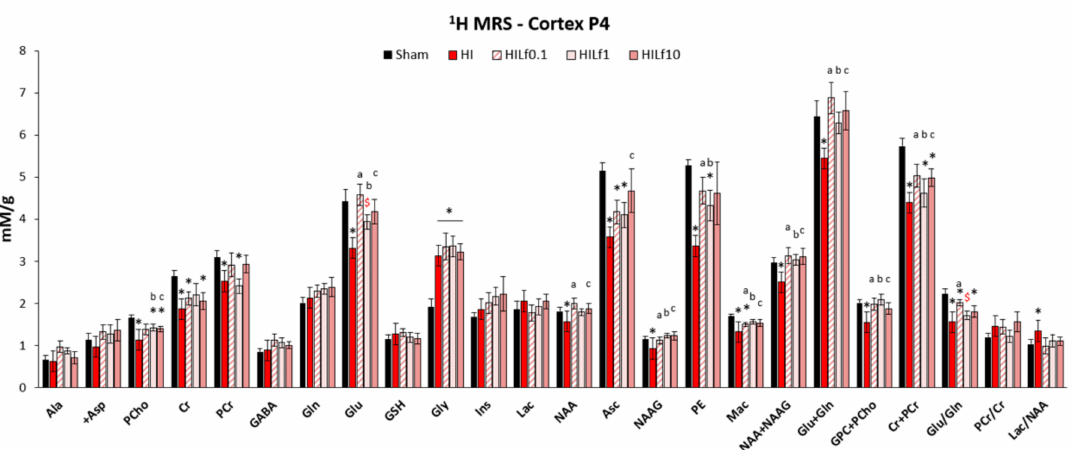
Figure 2. Neurochemical profiles presented as mean ± SEM. All concentrations are expressed in mM/g. Differences between groups (Sham, HI, HILf0.1, HILf1, and HILf10) 24 h post-HI ( p < 0.05, * HI vs. SH, $ difference between HILf groups. a b c HILf0.1, 1 or 10 vs. HI, respectively. Differences were determined by one-way ANOVA and considered significant when p < 0.05. Asc, ascorbate; Ala, alanine; +Asp, aspartate; Cr, creatine; GABA, gamma-aminobutyric acid; Gln, glutamine; Glu, glutamate; GSH, glutathione; Gly, glycine; Ins, myo-inositol; Lac, lactate; Mac, macromolecules; NAAG, N- acetylaspartylglutamate; NAA, N-acetylaspartate; PCho, phosphocholine; PCr, phosphocreatine; PE,